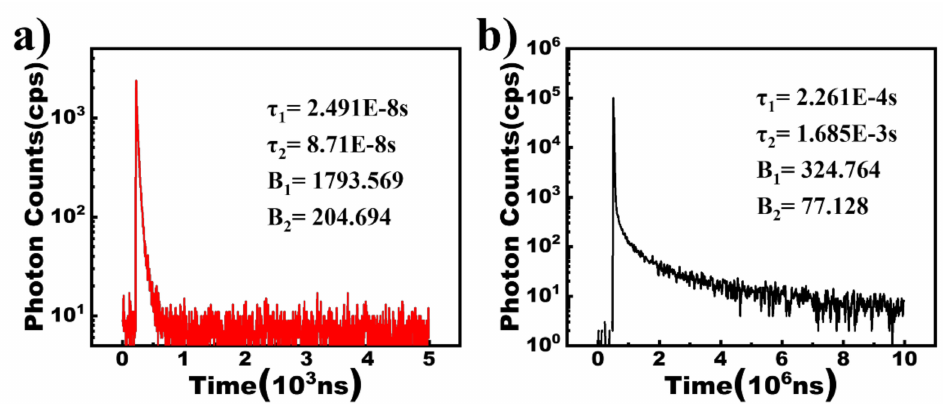
Figure 2. The time-resolved photoluminescence spectra of TCTA: TPBI (( a ), a short scale time for prompt fluorescence; ( b ), a long scale time for delayed fluorescence); the average lifetimes denoted as ∑ B i τ 2 i ∑ τ can be calculated by: τ = B i τ i